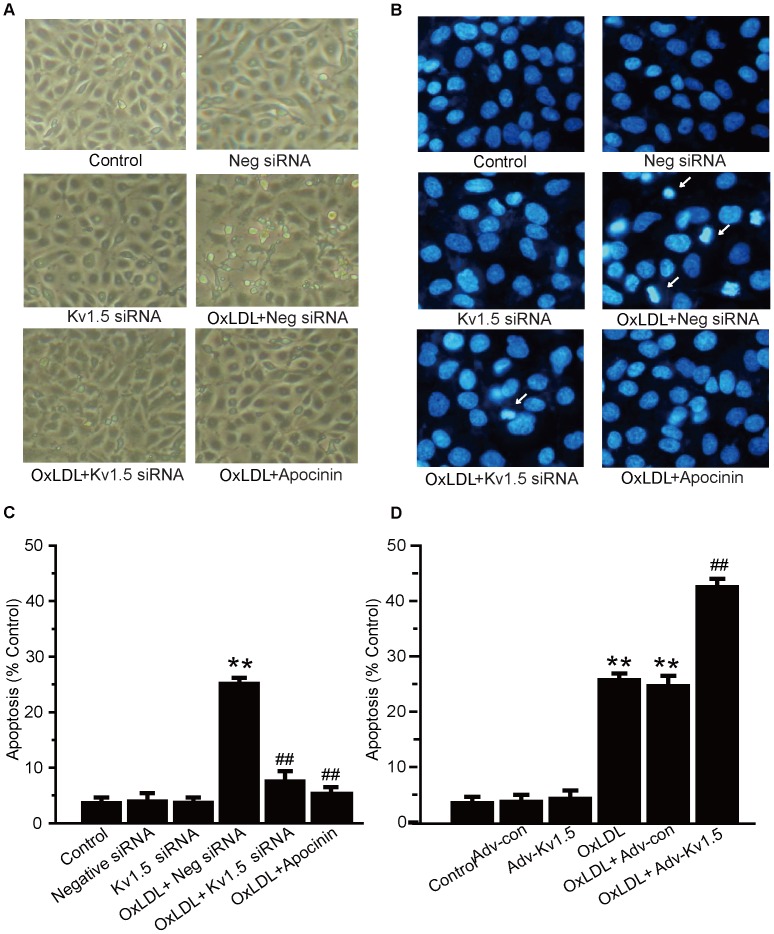
OxLDL-induced EC injury was attenuated by Kv1.5 siRNA, but aggravated by adnoviral Kv1.5 overexpression.HPAECs were transfected with Kv1.5 siRNA (10 nM) or control siRNA for 48 h, or infected with adnovirus containing KCNA5 and control–adnovirus for 24 h, then treated with oxLDL (150 µg/ml) for further 24 h. The oxLDL-induced EC injury was detected by optical microscopy and DAPI staining. The optical microscope observation (A) and DAPI staining (B) show the morphological changes in Kv1.5 siRNA pretreated HPAECs. The mean values of percentages of apoptotic cells were summarized after DAPI staining in Kv1.5 siRNA (C)- and KCNA5 adnovirus- pretreated (D) HPAECs. The values are presented as means ± SEM of 6 independent experiments. * P<0.05, ** P<0.01 vs. Vehicle control; # P<0.05, ## P<0.01 vs. Ad-con.